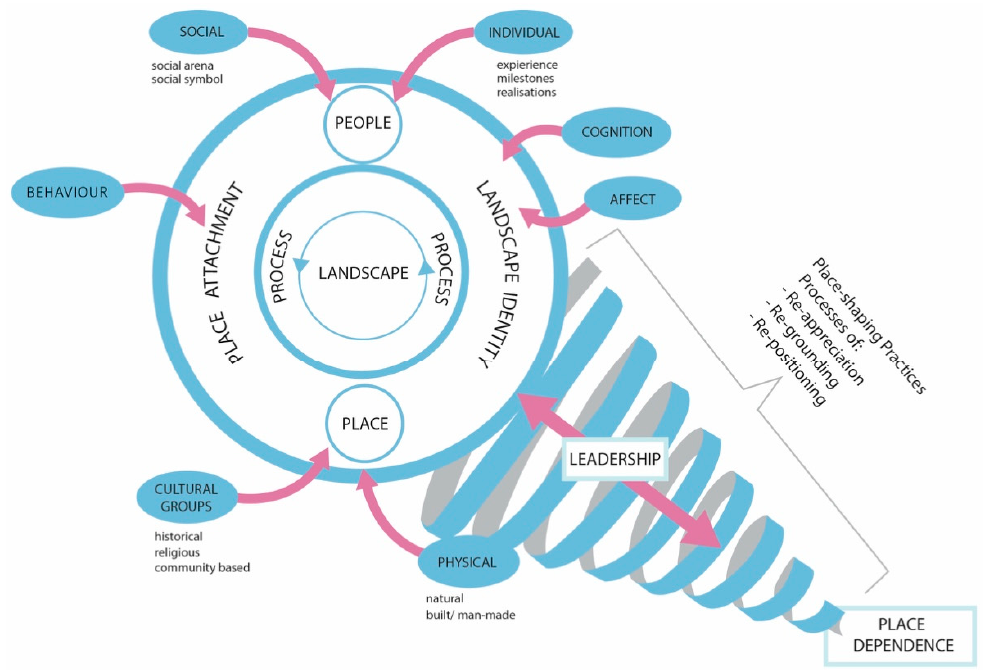
Figure 1. This figure puts landscapes at the heart of a sense of place (adapted from Storie et al. [11]). It illustrates how sense of place evolves through the interaction of place attachment and landscape identity based on a person’s experience within a landscape, where a person’s experience reflects how they perceive a place (cognition), the influence a place has on an individual (a ff ect), and the resulting behaviour it elicits. Social, cultural and physical aspects all play a part through the re-appreciation, re-grounding and re-positioning of landscape elements, which leads to a greater place dependence as a landscape meets the needs of an individual. Sustainable leadership, which is self-motivated, open, supportive and well-networked (see Table 1), can drive and encourage this process through actions that deepen landscape identity and increase place attachment, leading to greater place dependence. Likewise, increasing place dependence, for example through increased employment opportunities, can increase place attachment and landscape identity in a virtuous